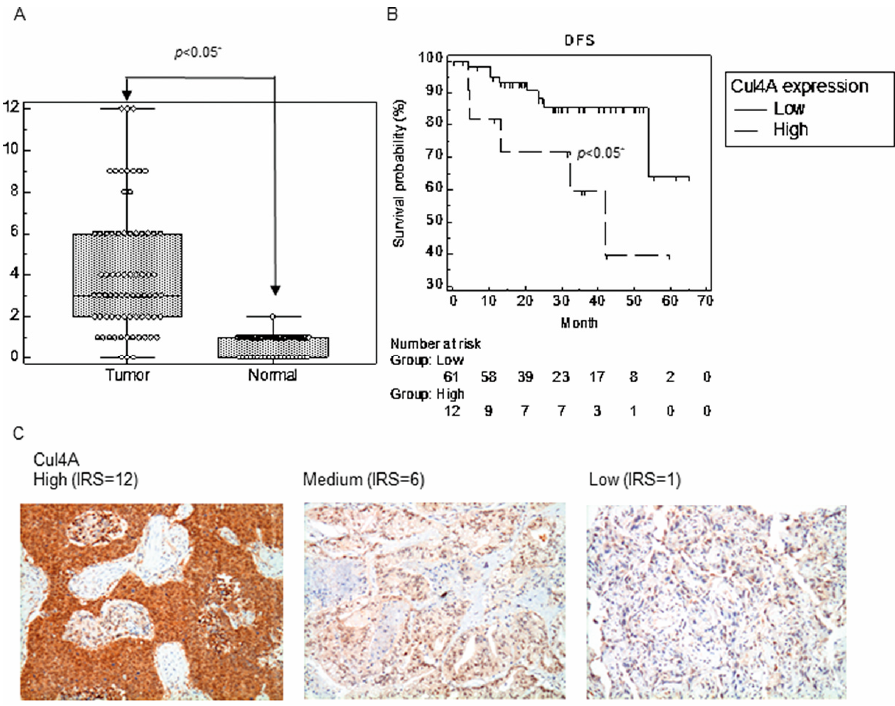
Figure 1. Cont . Figure 1.